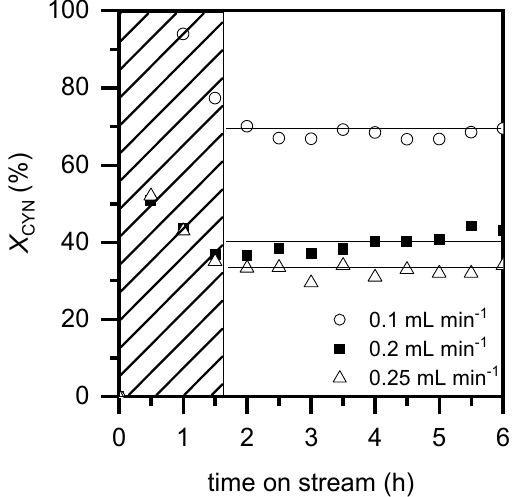
Figure 3. E ff ect of the feed flow rate on the removal of CYN upon CWPO ([CYN] 0 = 25 µ g L − 1 , Figure 3. Effect of the feed flow rate on the removal of CYN upon CWPO ([CYN] 0 = 25 μ g L − 1 , [H 2 O 2 ] 0 [H 2 O 2 ] 0 = 2 mg L − 1 , W Fe3O4 = 14 g, pH 0 = 5, T = 25 ◦ = 2 mg L − 1 , W Fe3O4 = 14 g, pH 0 = 5, T = 25 °C).